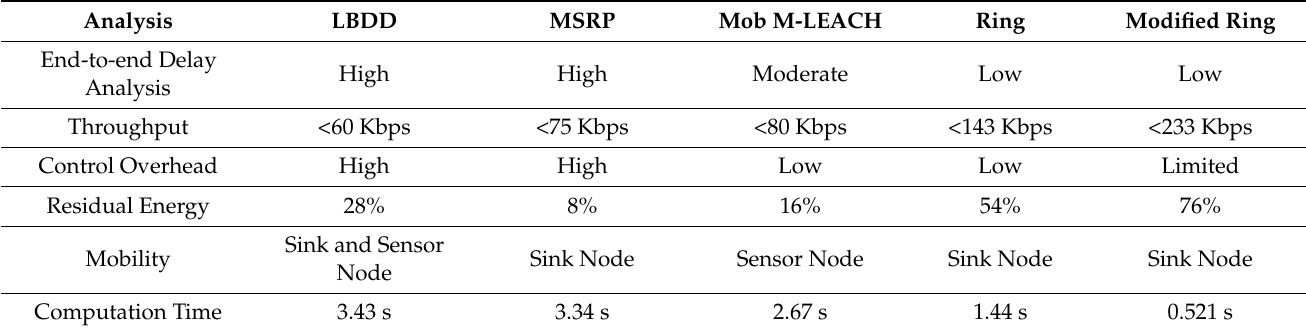
Table 3. Average complexity analysis for the dynamic sensor